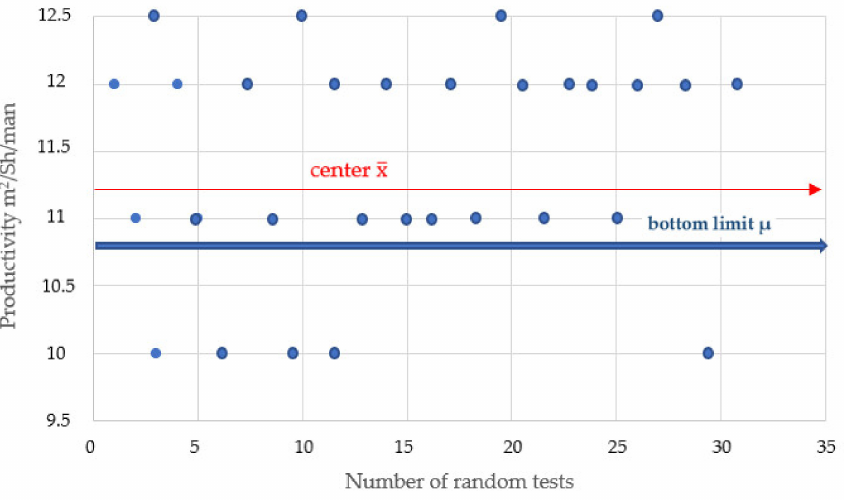
Figure 10. Graphic illustration of the plaster works performances including the mean